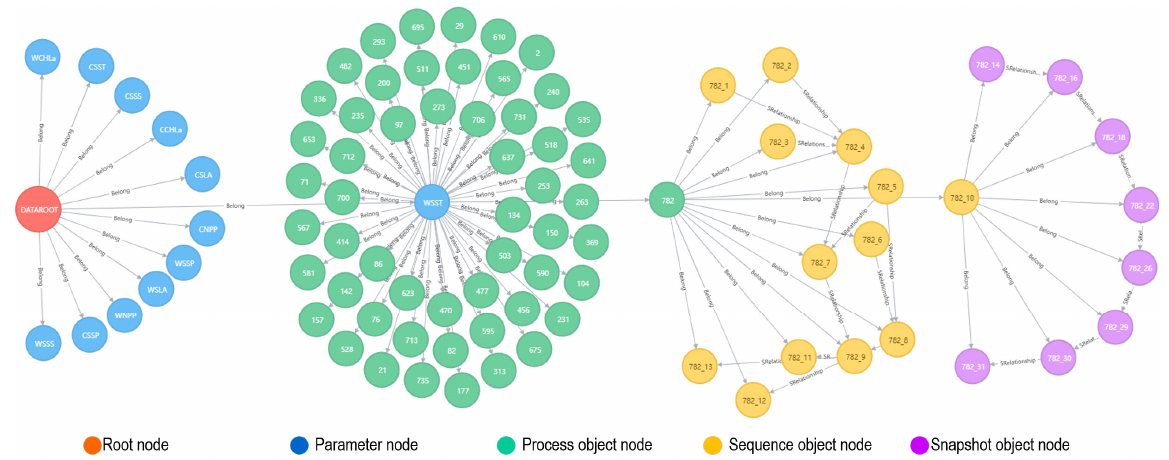
Figure 10. Hierarchical view structure of PoGDB.